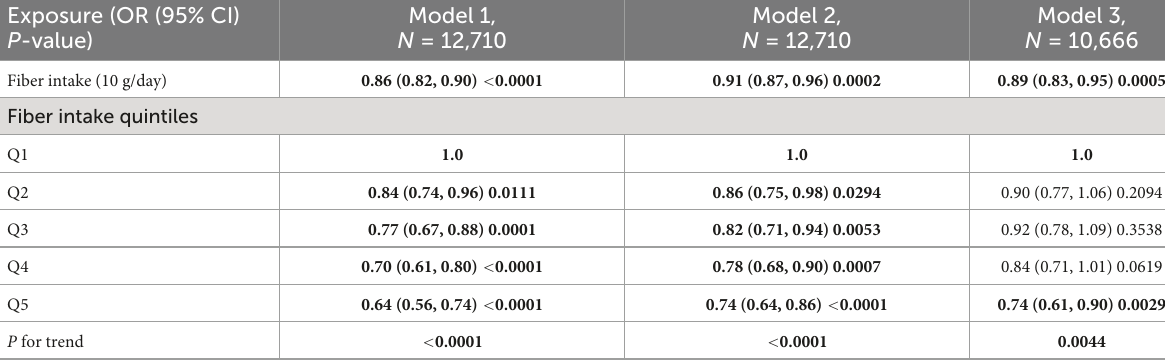
TABLE 2 Association between severe headache or migraine with fiber intake (raw data). Exposure (OR (95% CI) P -value)